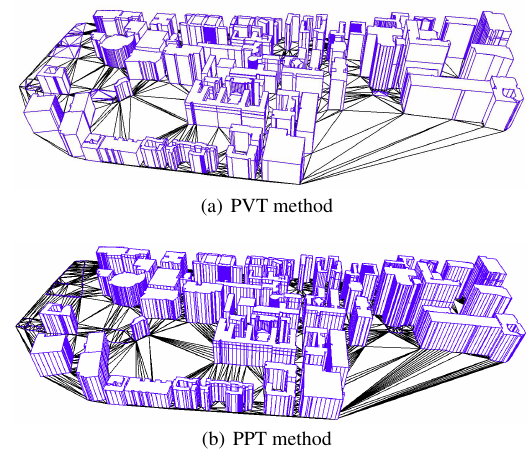
Figure 12. The 3D buildings with